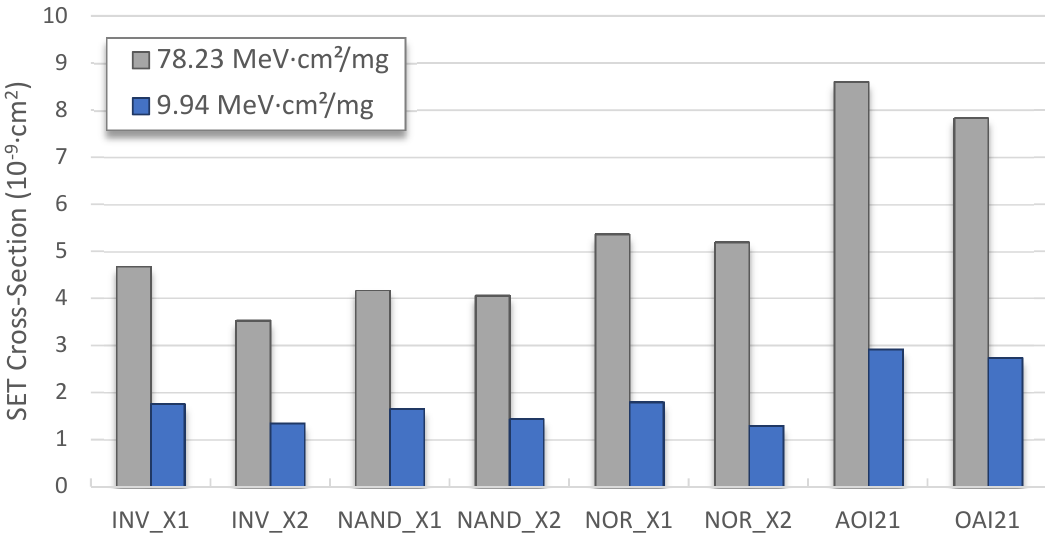
Figure 4. SET cross-section for eight standard-cell gates from the 45 nm NanGate [33], for Linear Energy Transfer (LET) = 78.23 and 9.94 MeV · cm 2 /mg.